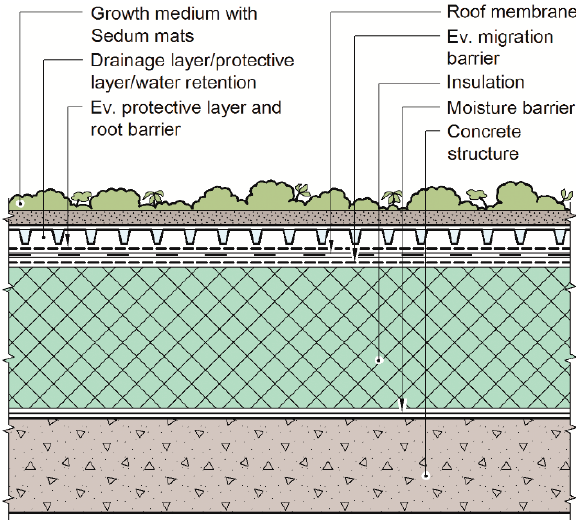
Figure 1. Example of a blue-green roof assembly. The thickness of the growth medium may be vastly increased for intensive green roofs. The water storage and drainage layer shown is based on extruded plastic boards, but this layer may also consist of gravel or crushed baked clay. Alternate concepts for blue-green roof assemblies also exist, see, for instance, [12]. Illustration ©SINTEF.